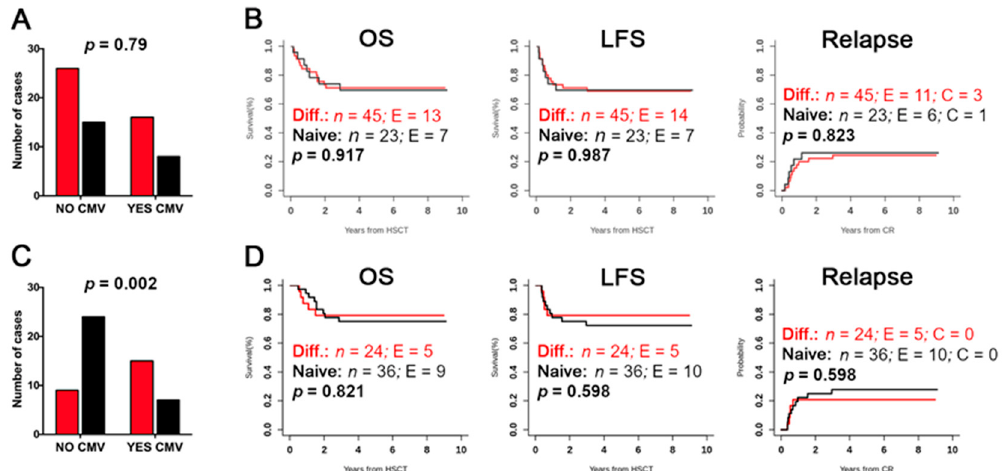
Figure 5. Correlation analysis of clusters with clinical outcome. The clusters identified in donors ( n = 68) ( A , B ) and patients at 3–6 months after HSCT ( n = 60) ( C , D ) have been analyzed for possible association with HCMV reactivation, OS, LFS, and cumulative incidence for Relapse. While the di ff erentiated (red columns) versus naïve (black columns) phenotype of donor NK cells ( A ) did not predispose to HCMV reactivation after haplo-HSCT ( p = 0.79), the di ff erentiated phenotype of post-transplant NK cells ( C ) was highly associated with HCMV reactivation (** p = 0.002). Significance was calculated by the χ 2 test. OS, LFS, and Relapse according to di ff erentiated and naïve NK-cell repertoires identified in donors ( B ) and post-HSCT patients ( D ) are shown. Fischer’s exact text. No significant p -values were detected.